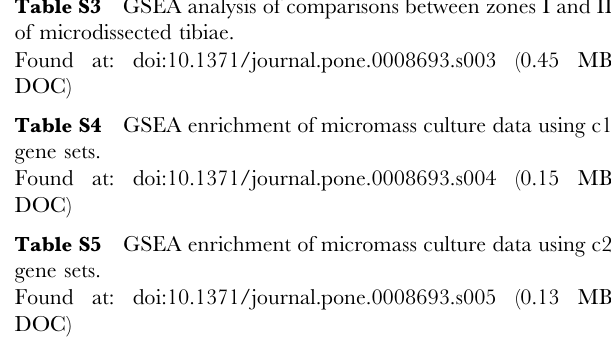
Table S3 GSEA analysis of comparisons between zones I and II of microdissected tibiae.